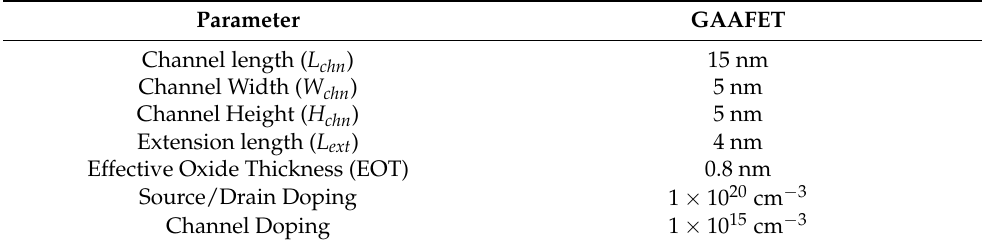
Figure 1. 3D structure of simulated GAAFET. Table 1. Device parameters.